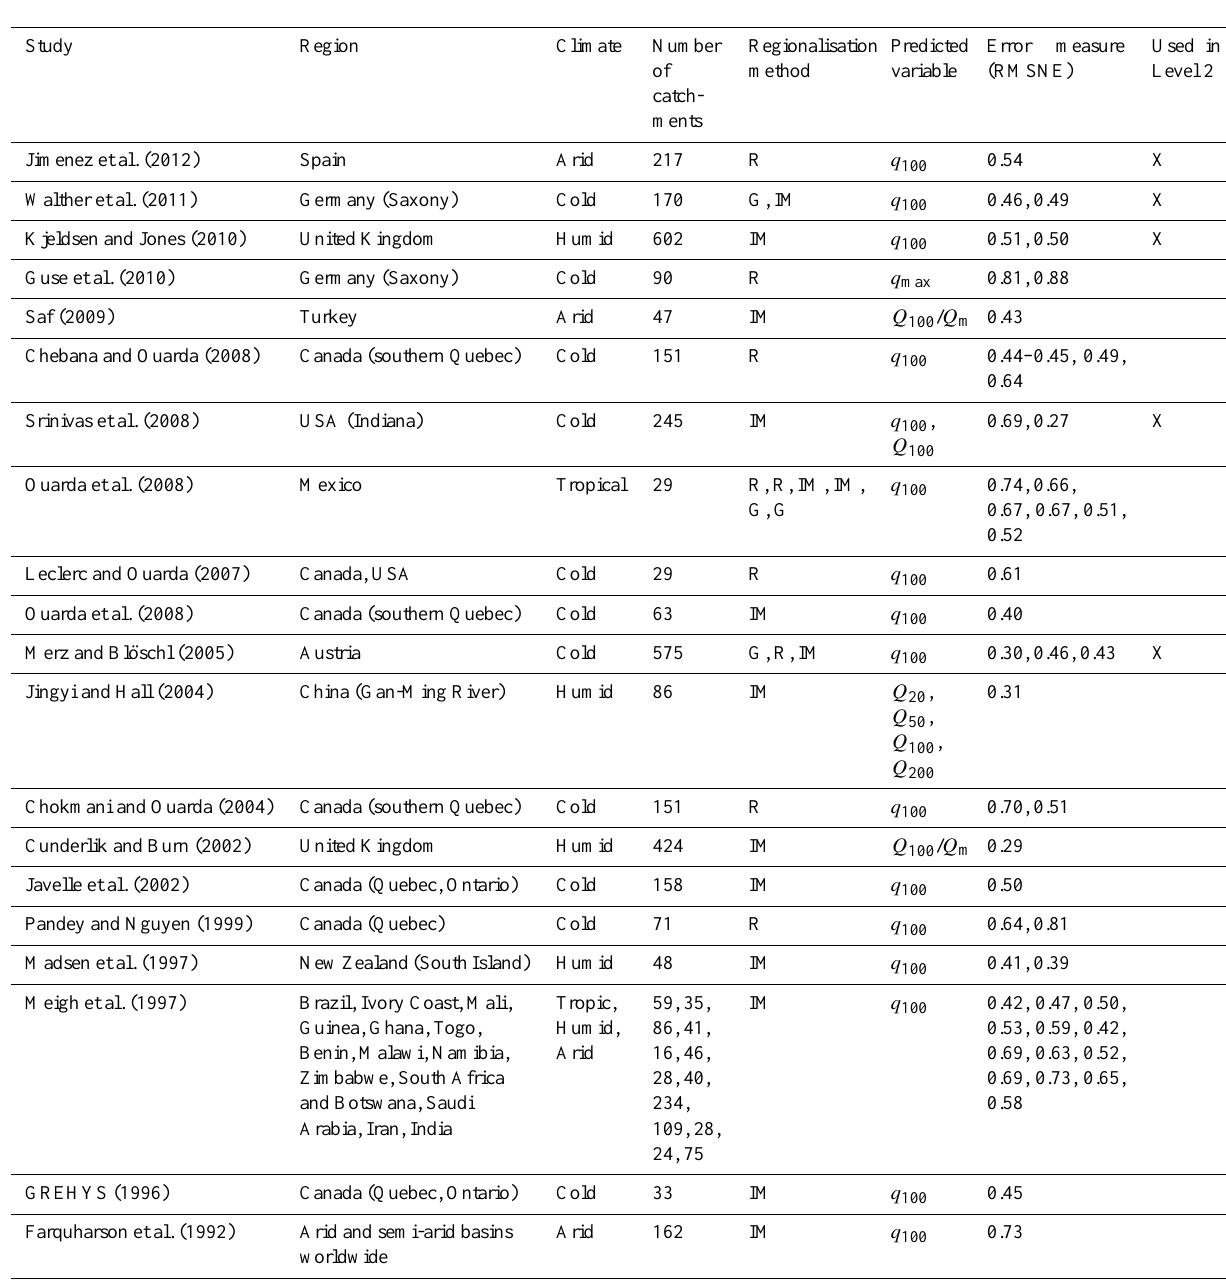
Table 3. Summary assessment of studies for flood estimation in ungauged catchments used in Level 1 assessment. Error measure indicates the leave-one-out assessment of model efficiency in terms of the root mean square normalised error RMSNE. Flood regionalisation methods include: regression methods (R), index methods (IM) and geostatistics (G). Predicted variable indicates the flood discharge estimated in the study and includes: 100yr specific flood runoff ( q 100 ) , 100yr flood runoff ( Q 100 ) and 100yr flood runoff standardised by the mean annual flood ( Q 100 / Q m ) . Ranges or various values for RMSNE represent variations of the methods or the same method applied on different subsamples from the same